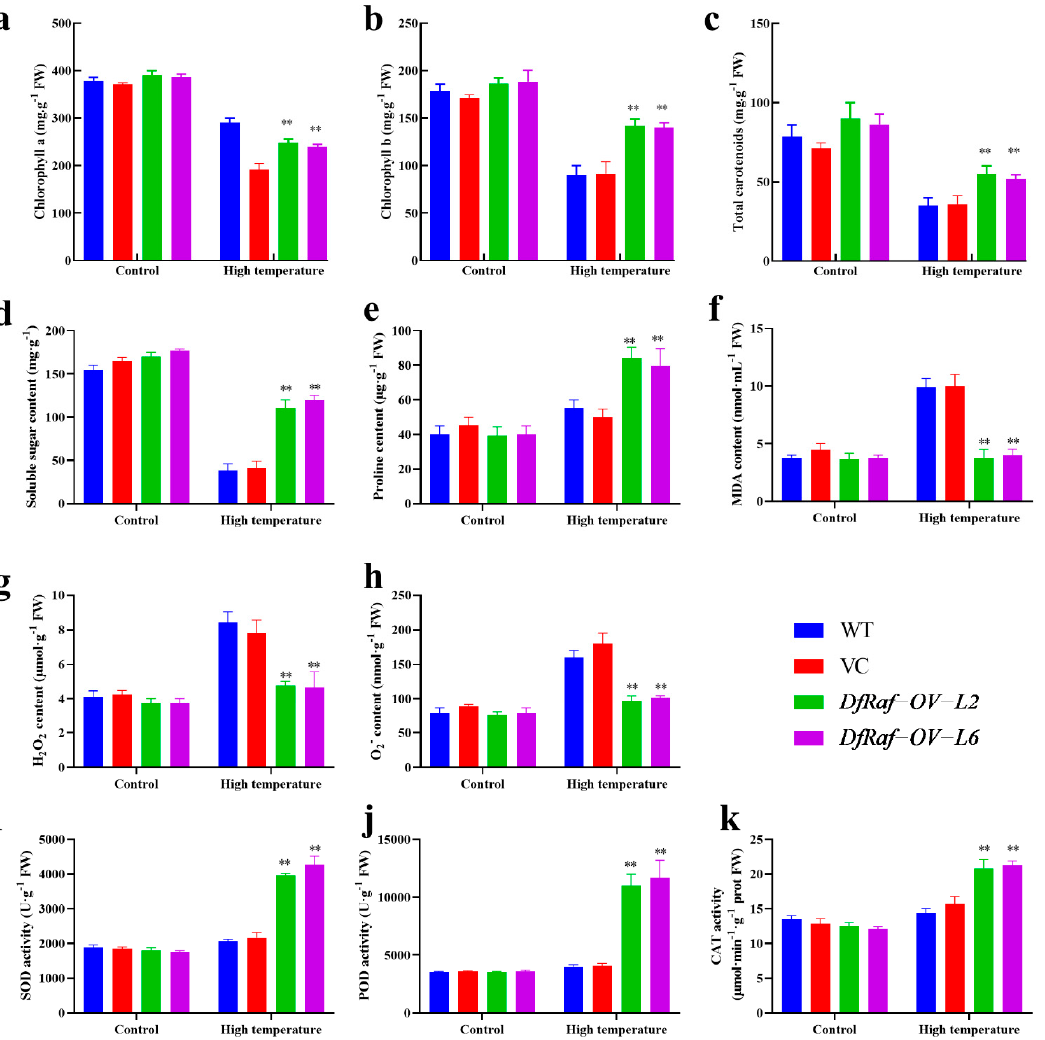
Figure 8. Physiological indices of DfRaf overexpression lines under heat stress. The content of chlorophyll a ( a ), chlorophyll b ( b ), total carotenoids ( c ), soluble sugar ( d ), proline ( e ), MDA ( f ), H 2 O 2 ( g ), O 2 − ( h ) and the activity of SOD ( i ), POD ( j ) and CAT ( k ) of tobacco lines under heat stress; Each bar in the graph corresponds to the mean value ± SD of three independent replicates. ** p < 0.01.